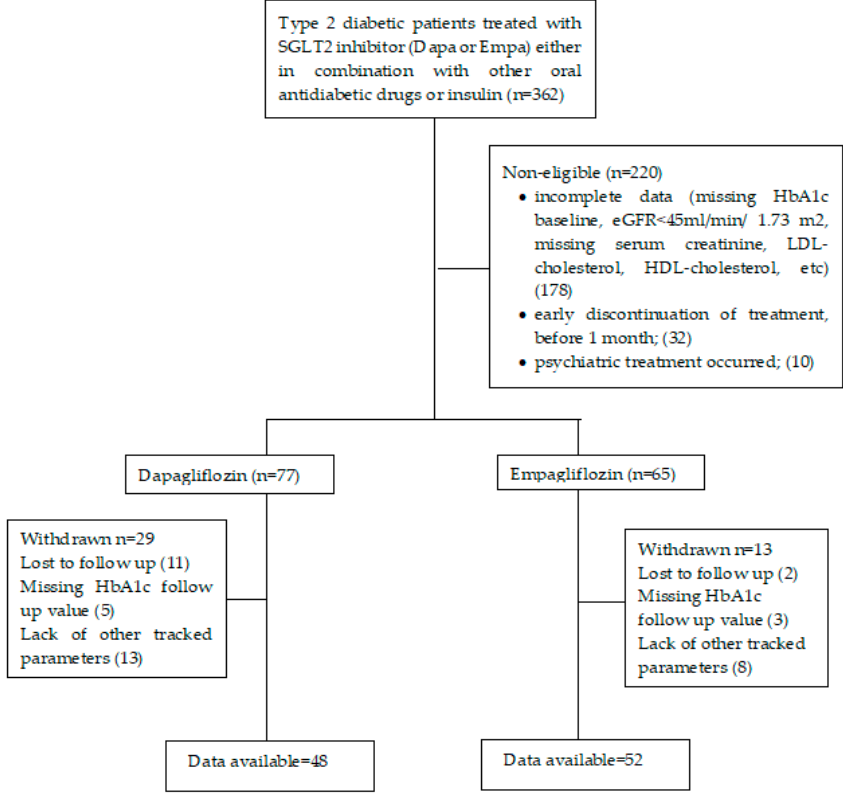
Figure 1. Flow chart of the study. Eligible patients were over 18 years with T2DM and associating dyslipidemia and/or cardiovascular disease who had been treated with dapagliflozin or empagliflozin, a criterion that divided the study group into two subgroups: Dapa group—48 patients treated